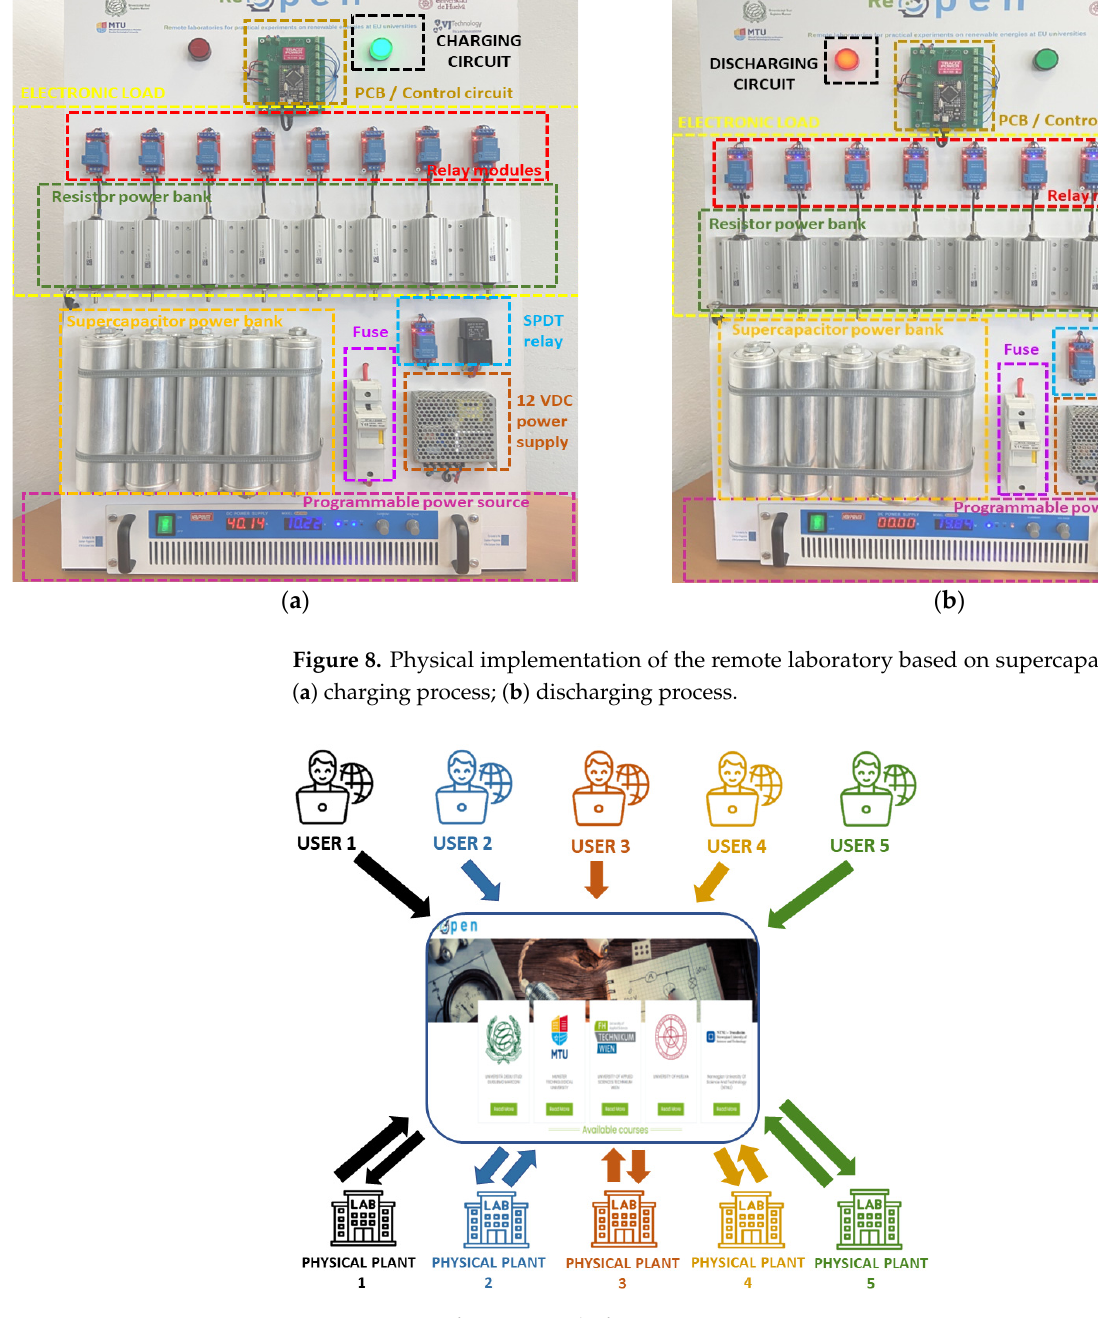
Figure 9. LMS of REOPEN platform.